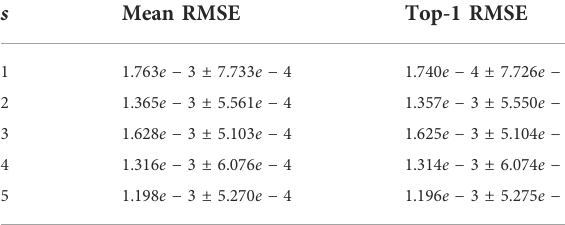
TABLE 3 Mean and top-1 RMSE of the parameter g AMPA, i